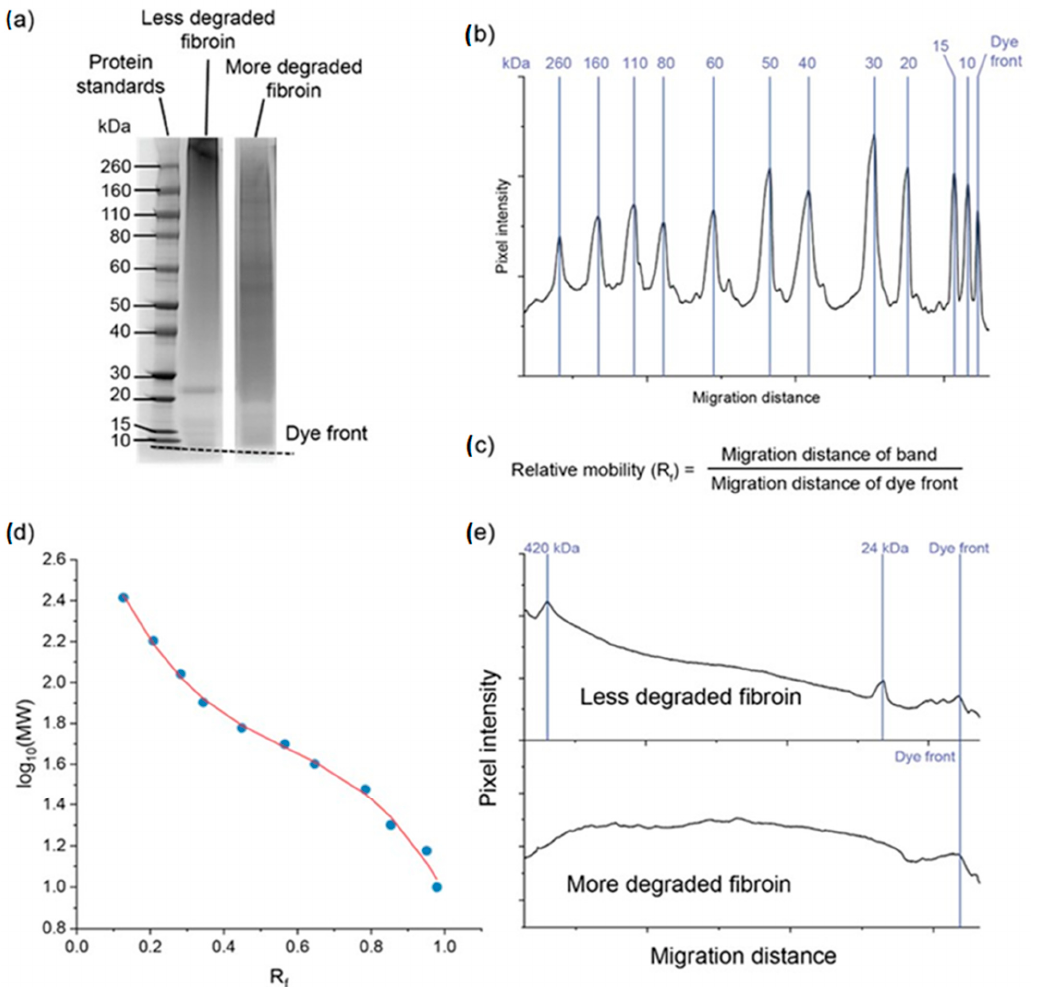
Figure 6. Process for determining the molecular weight (MW) of silk using SDS-PAGE. Image ( a ) shows Bombyx mori silk samples prepared under di ff erent conditions run on a NuPAGE 3 − 8% Tris- acetate gel (ThermoFisher Scientific, Waltham, MA, USA). ( b ) Plot of the migration of the protein standard down the gel lane with protein standard peaks identified using the Gel Molecular